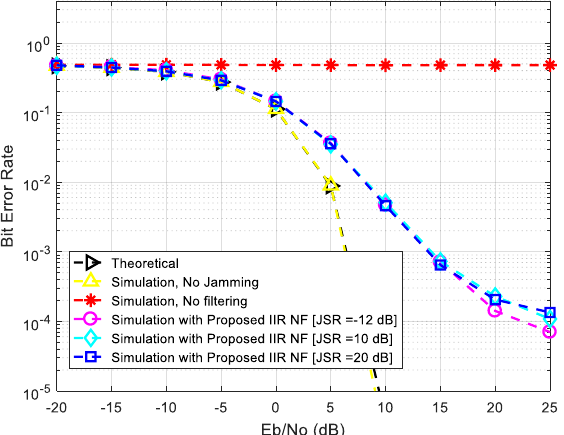
Figure 10. BER vs. E b